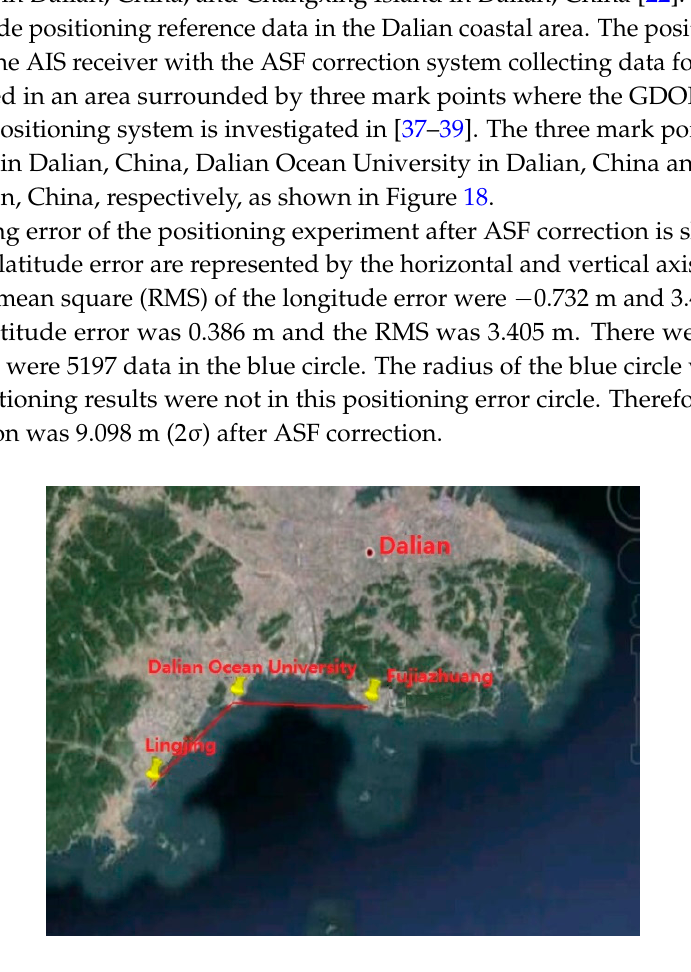
Figure 18. The locations of the three mark points in the static experiment.